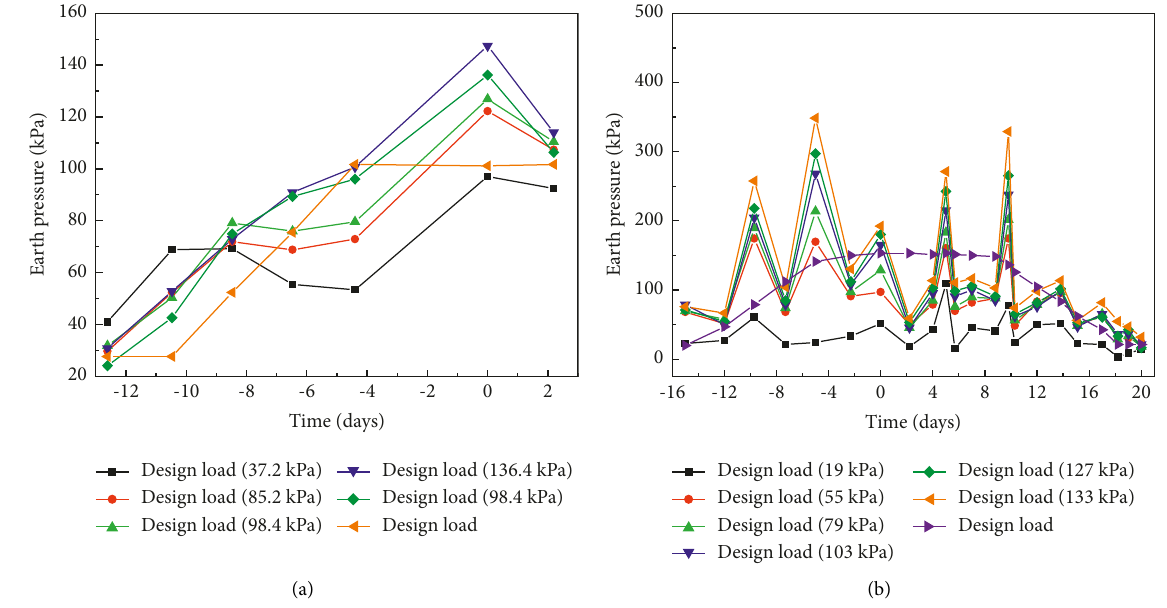
Figure 3: Relationship between Earth pressure distribution along the base and the time: (a) Natural foundation (DK87+155 section); (b) composite foundation (DK87 +185 section).